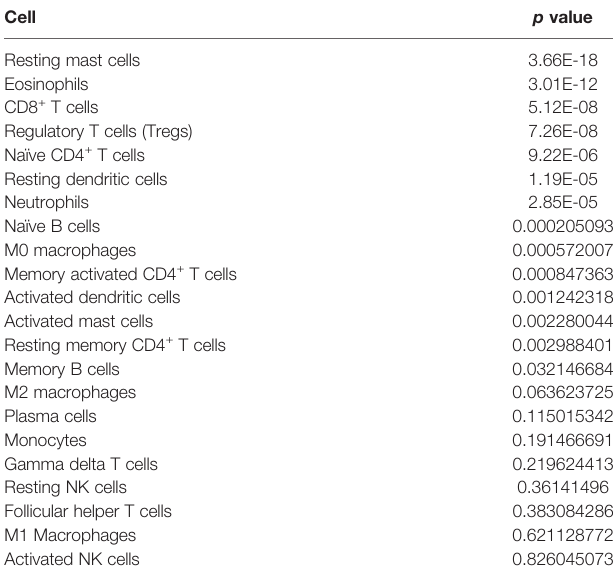
TABLE 3 | Rank-sum test of the proportion of each immune cell in the two groups. Cell p value Resting mast cells